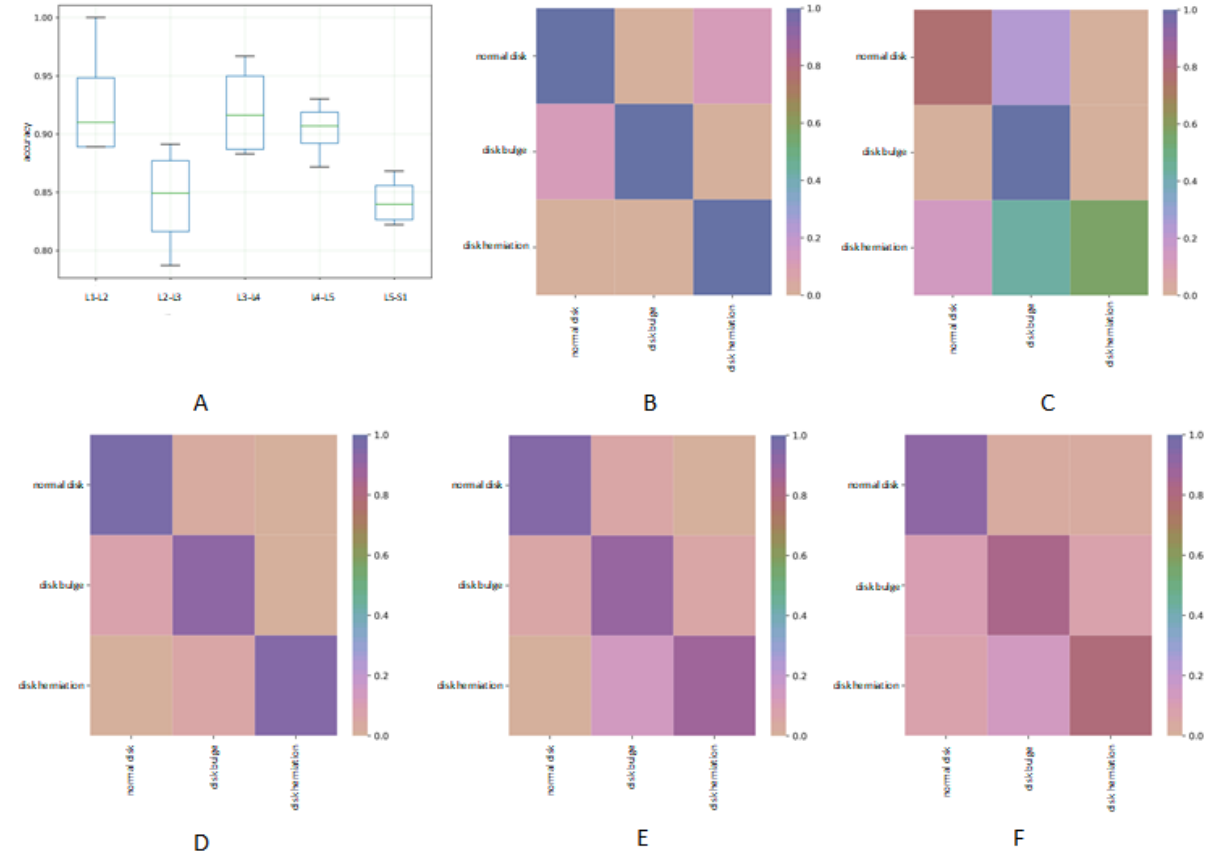
Figure 4. Results of the 3-class classification (normal disk, disk bulge, and disk herniation). (A) The average accuracies of the classification system (calculated using ResNet101) for the following five categories: L1-L2, L2-L3, L3-L4, L4-L5 and L5-S1. The rows and columns of all heat maps represent ground truth labels and predicted labels, respectively. The x-axis shows the five intervertebral disks. (B) A heat map of the classification accuracies for category L1-L2. The color scale expresses the accuracy. (C) A heat map of the classification accuracies for category L2-L3. The color scale expresses the accuracy. (D) A heat map of the classification accuracies for category L3-L4. The color scale expresses the accuracy. (E) A heat map of the classification accuracies for category L4-L5. The color scale expresses the accuracy. (F) A heat map of the classification accuracies for category L5-S1. The color scale expresses the accuracy. L: lumbar vertebra; S: